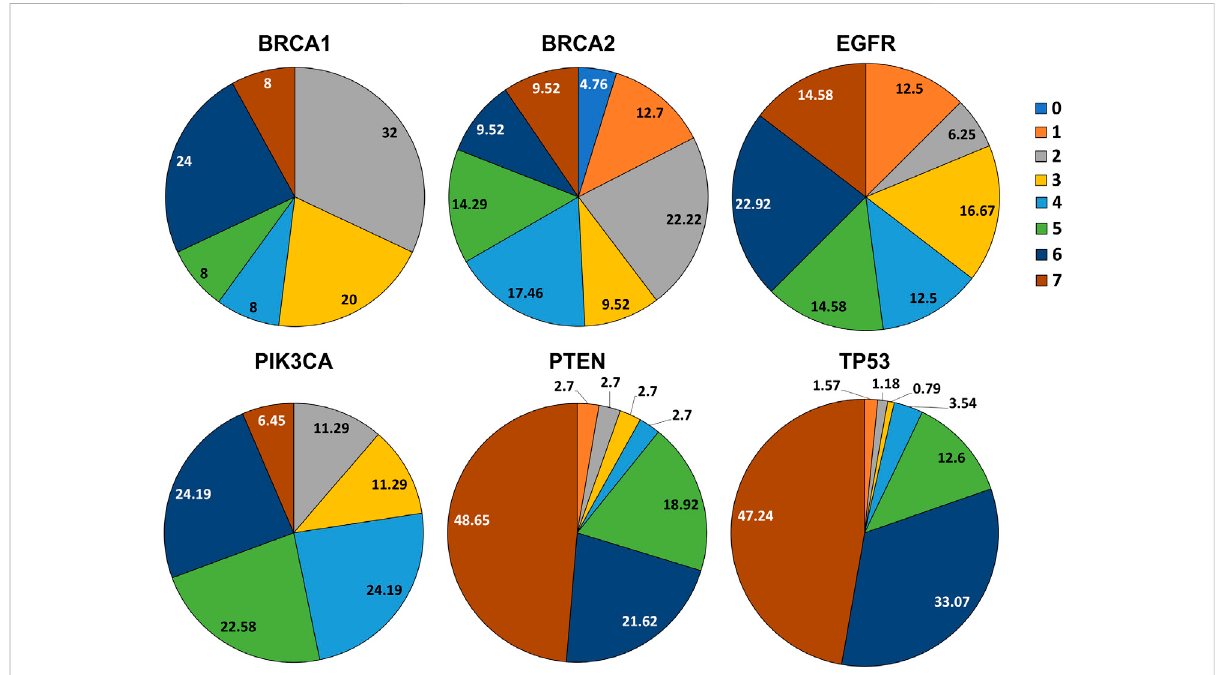
FIGURE 3 Pie charts representing the percentage of SNPs scored by the framework which overlapped with the alterations derived from patient suffering from breast cancer and